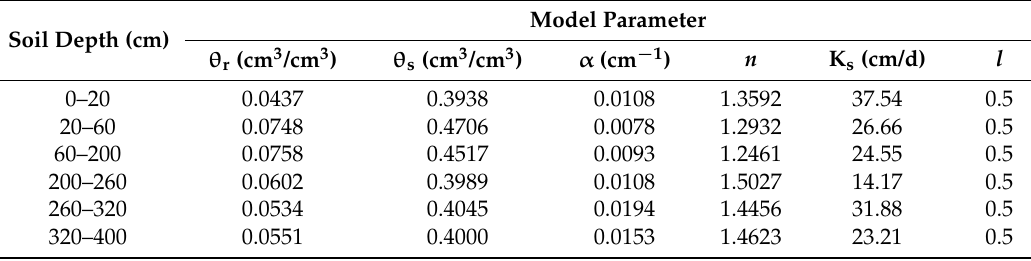
Table 3. Final soil hydrologic parameters for the different soil layers in the Hebei Low Plains study area in North